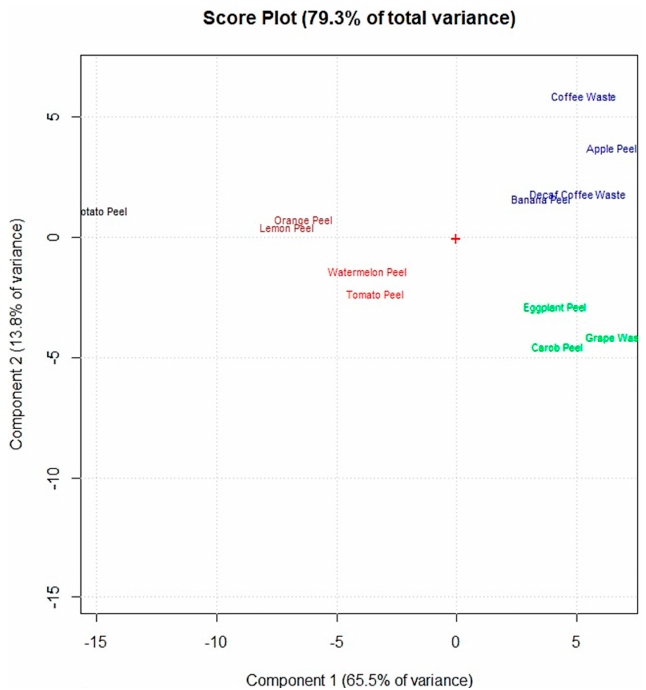
Figure 3. Score plot of the principal component analysis performed on the obtained FTIR spectral data of the 12 food waste